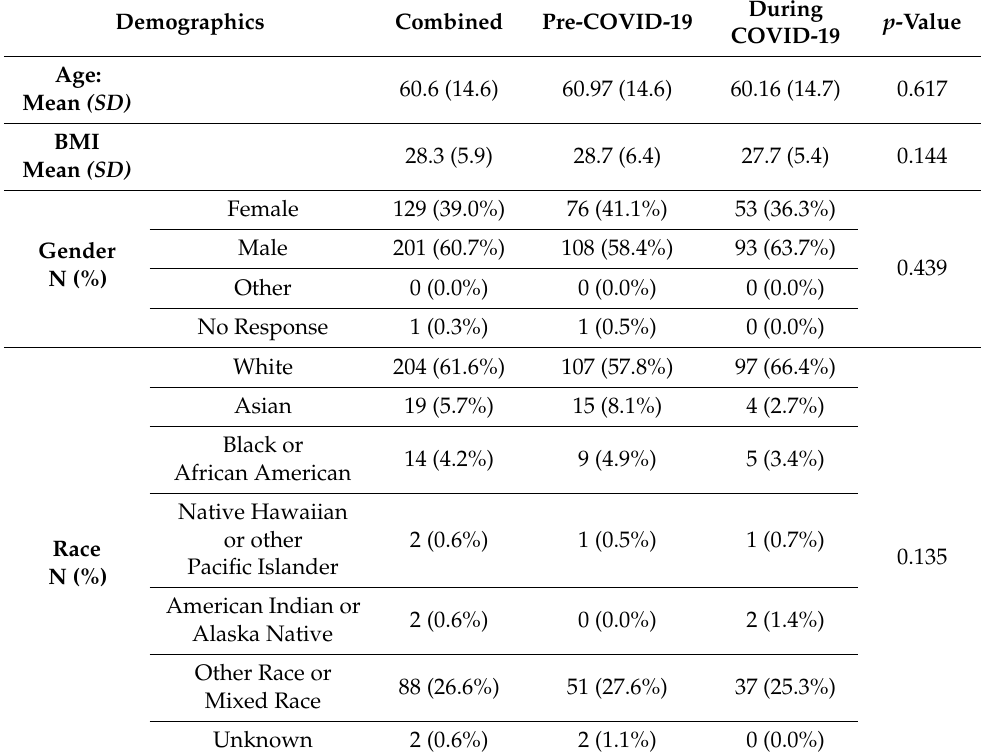
Table 1. Comparison of Demographic Data Pre COVID-19 and During